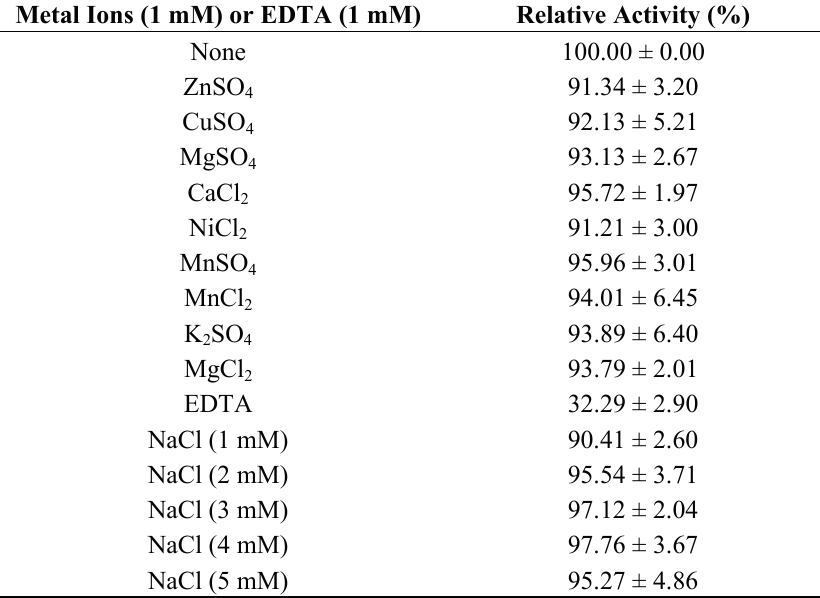
Table 1. Effect of various metal ions on the enzyme activity of MAJ1.